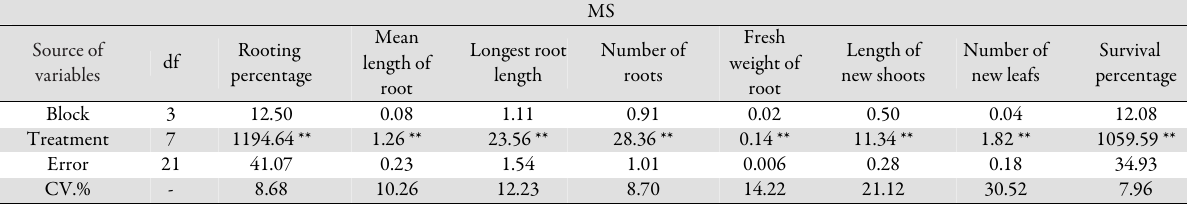
Tab. 1. Analysis of variance of treatments effect upon the measured traits